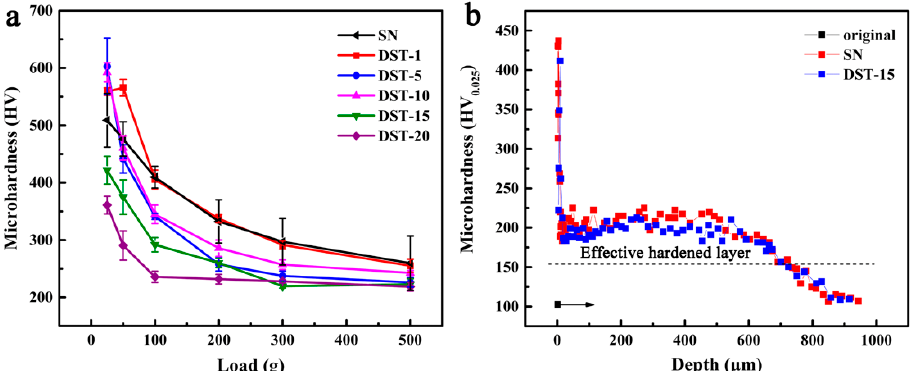
Figure 8. ( a ) Surface microhardness of the SN sample and DST samples; ( b ) Microhardness depth curves of the original material, the SN sample, and the DST-15 sample.